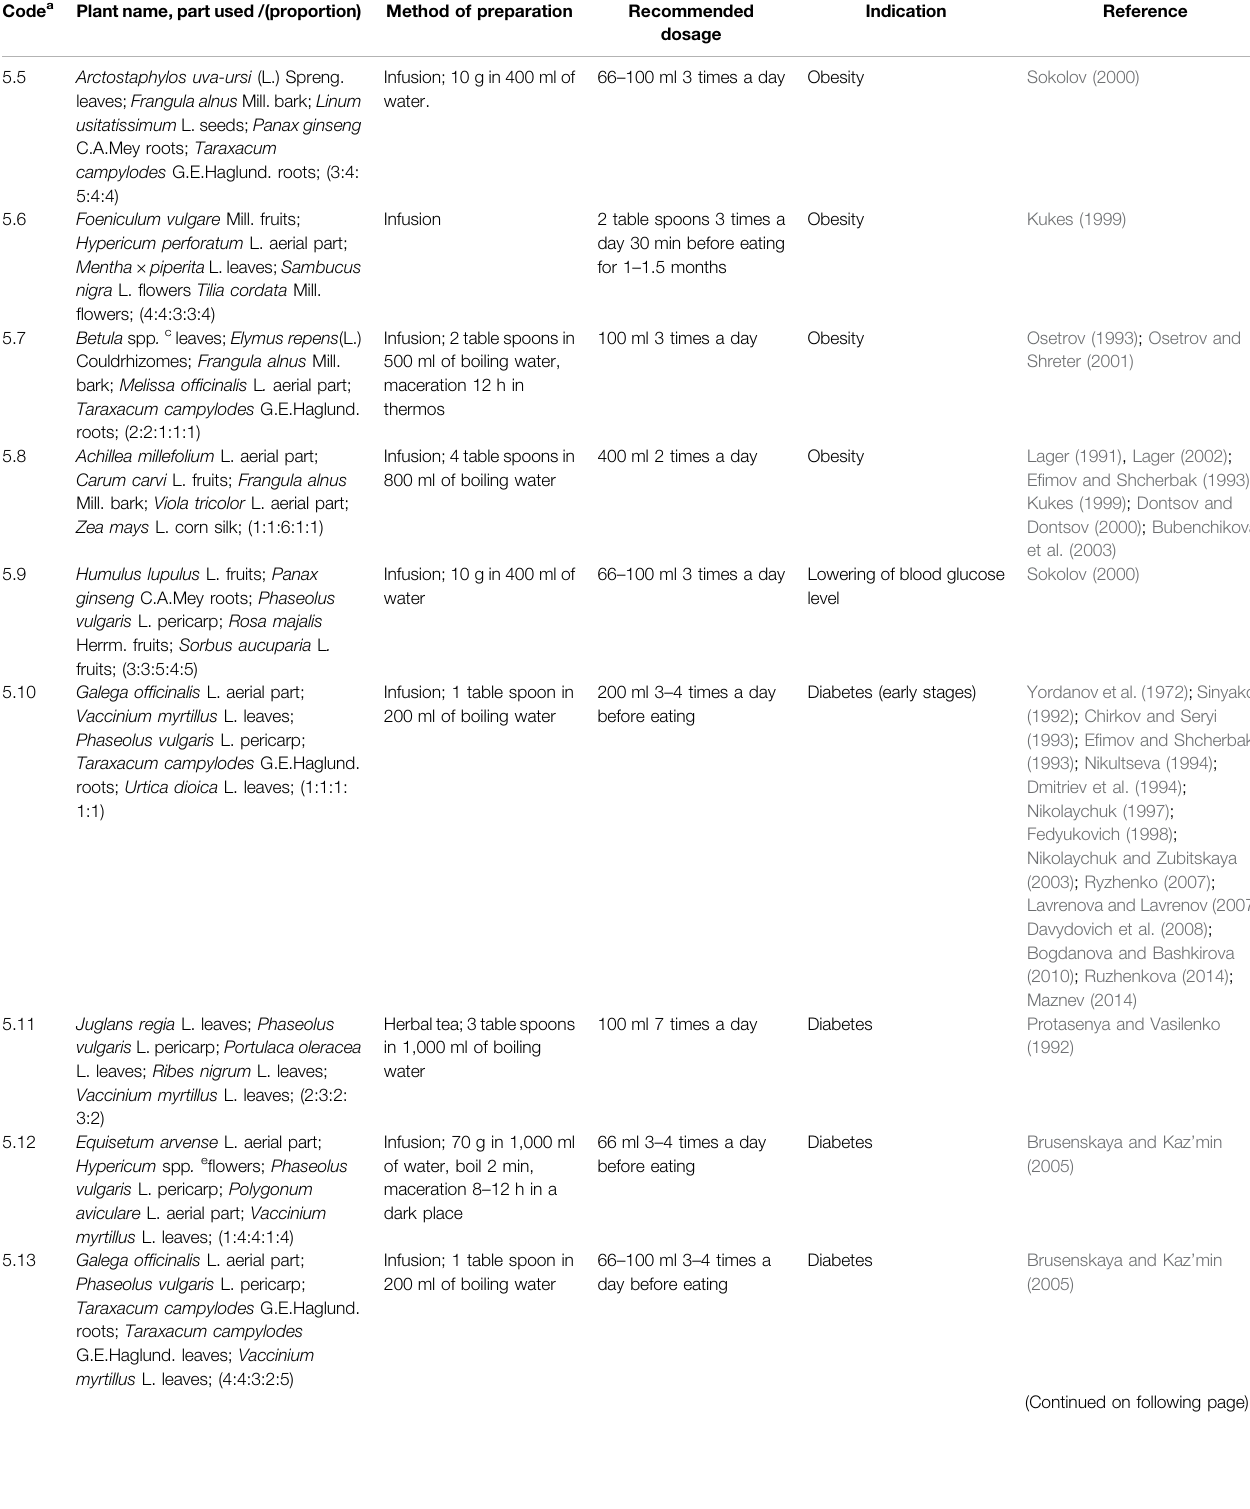
TABLE 1 | ( Continued ) The list of medical species used for the management of diabetes and related disorders in Russia. Code a Plant name, part used /(proportion) Method of preparation Recommended